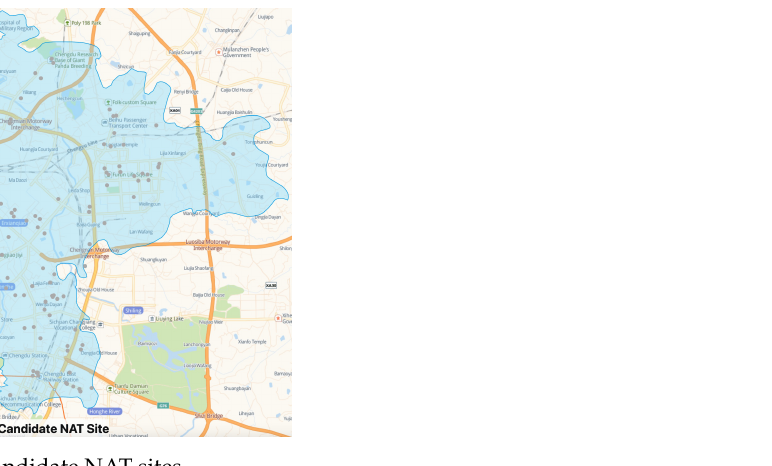
Figure 3. All candidate NAT sites.